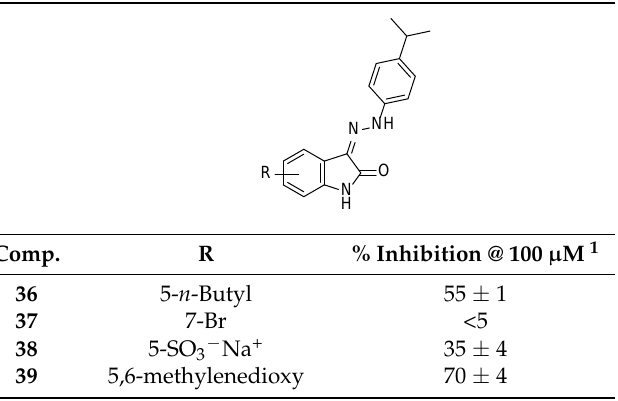
Table 5. A β Antiaggregating Activity of Compounds 36-39.